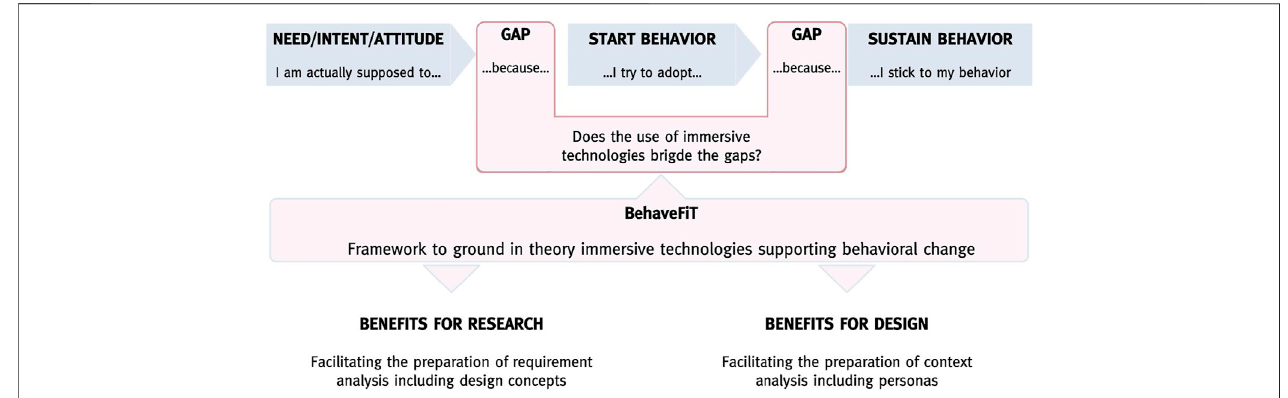
FIGURE 1 | The teaser fi gures shows the contribution of the Behavioral Framework of Immersive Technologies - BehaveFIT.